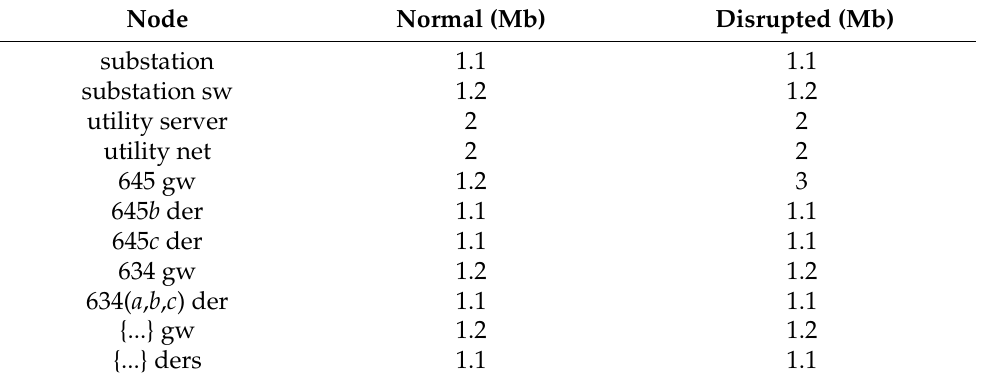
Table 4. Backlog for